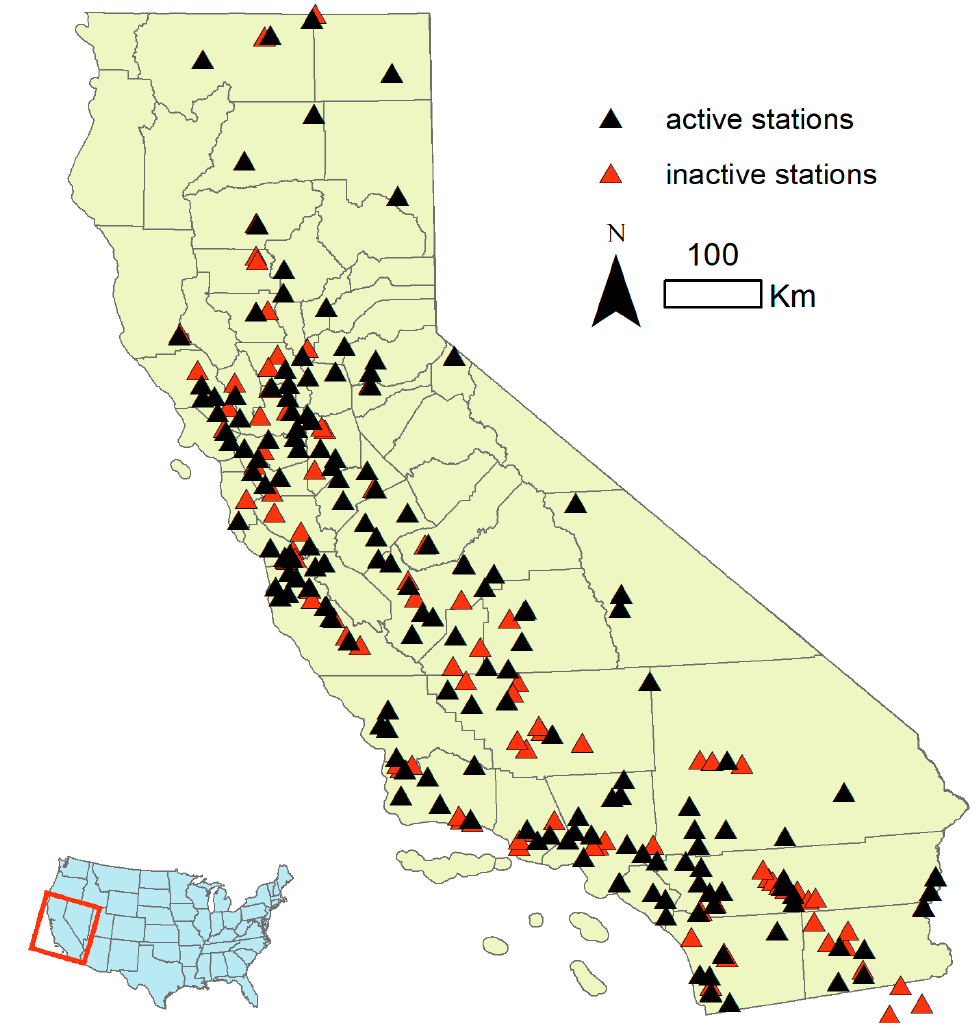
Figure 1. Weather monitoring stations in the study area.